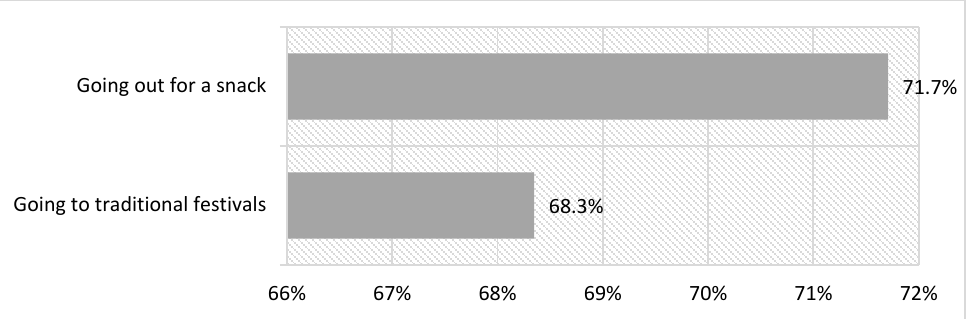
Figure 3. Festive leisure activities practiced.